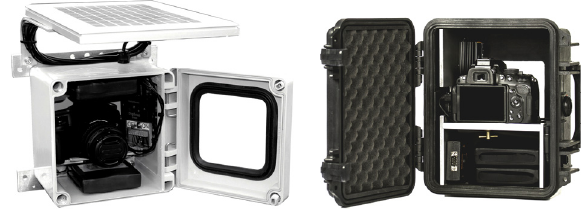
Figure 2. Time-lapse systems; RGB-system (adapted from: www.harbortronics.com), IR-sensitive system (left to right).